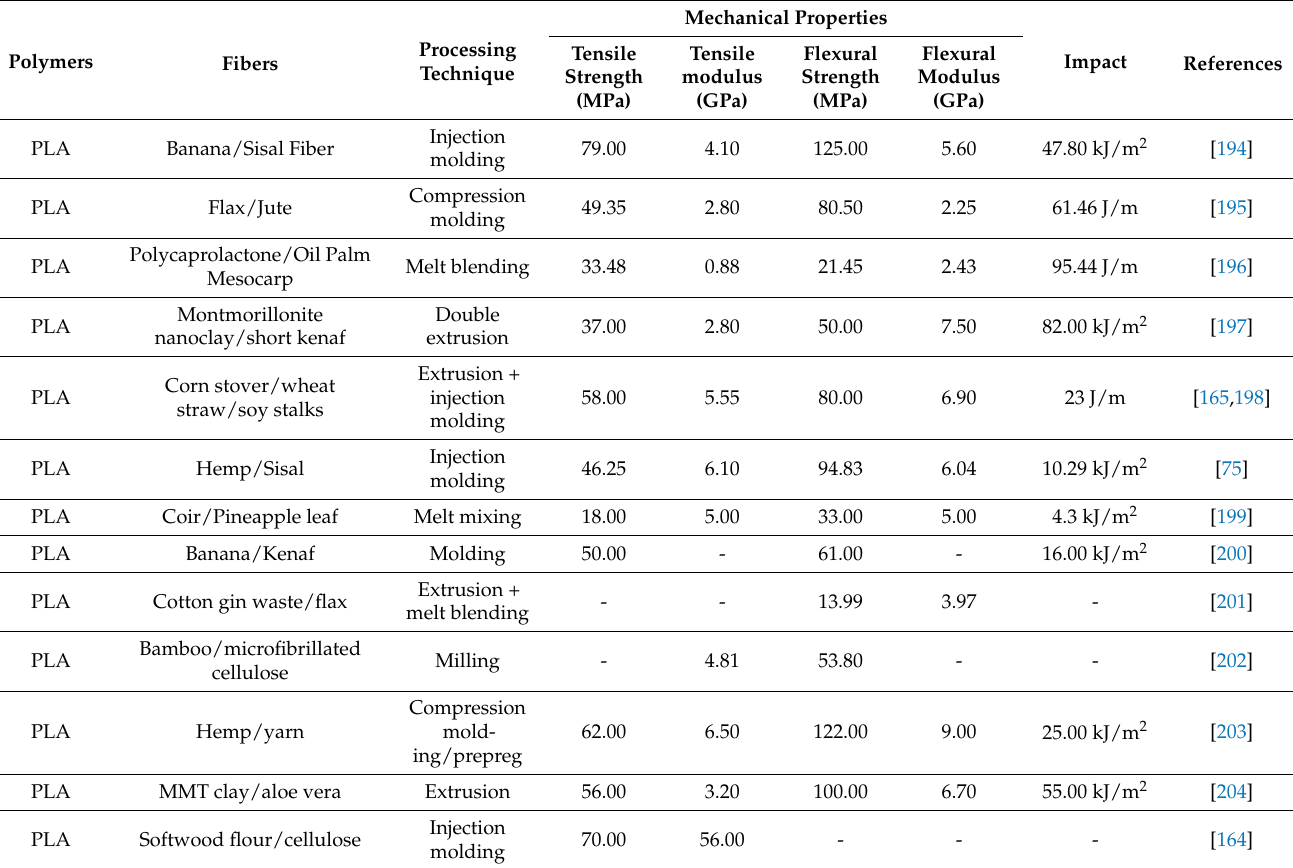
Table 10. Mechanical properties of PLA hybrid